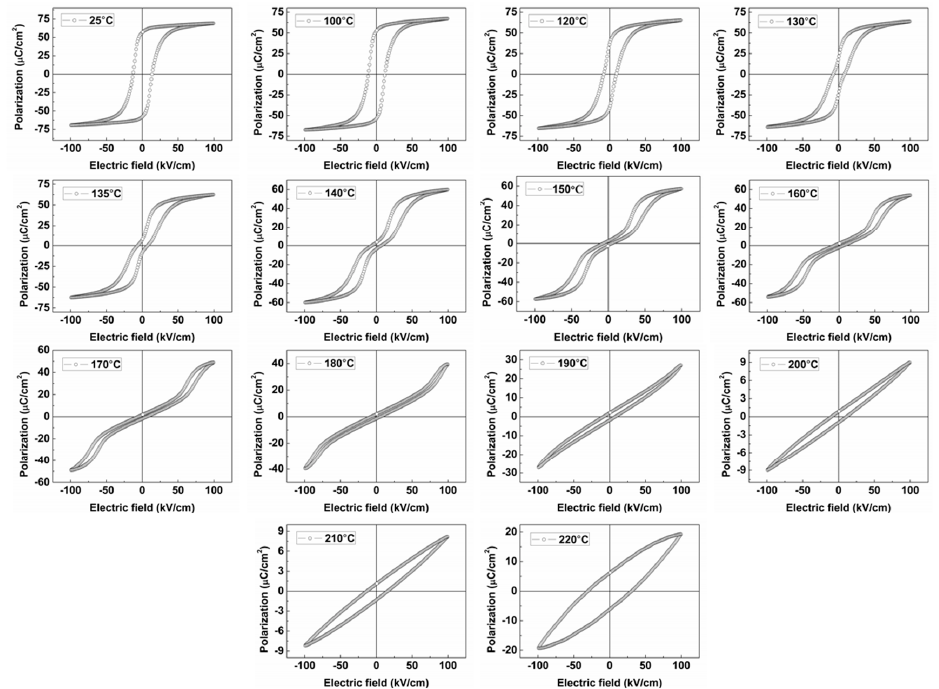
Figure 7. Polarization versus electric field ( P-E ) loops for the [111]-oriented plates of PLN-0.07PT crystal at various temperatures ( f = 2 Hz).